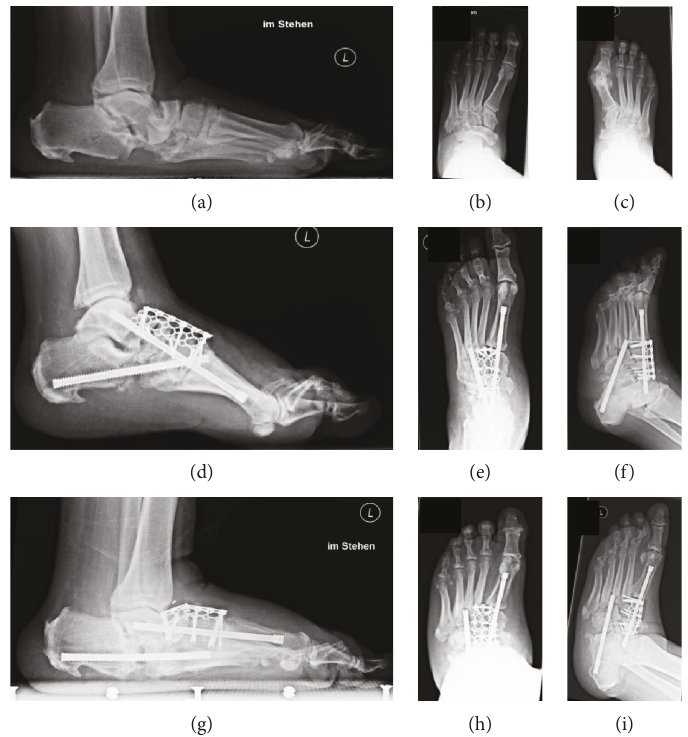
Figure 1: Radiologic case series of a 56-year-old male patient with IDDM for 19 years and severe midfoot Charcot arthropathy-type Sanders/ Frykberg II/III on the left foot, with subluxation in the talocalcaneal and talonavicular joints. Initial diagnosis made in October 2013 after trivial distortion of the upper ankle joint (a – c) bearing radiographs in lateral, anterior-posterior, and oblique views. Intra- and extramedullary implants were used for reconstructive arthrodesis of the medial and lateral midfoot columns (d – f). Radiographs 6 months after surgery reveal a loss of reduction and implant breakage, displaying a frequent problem in Charcot surgery (g –